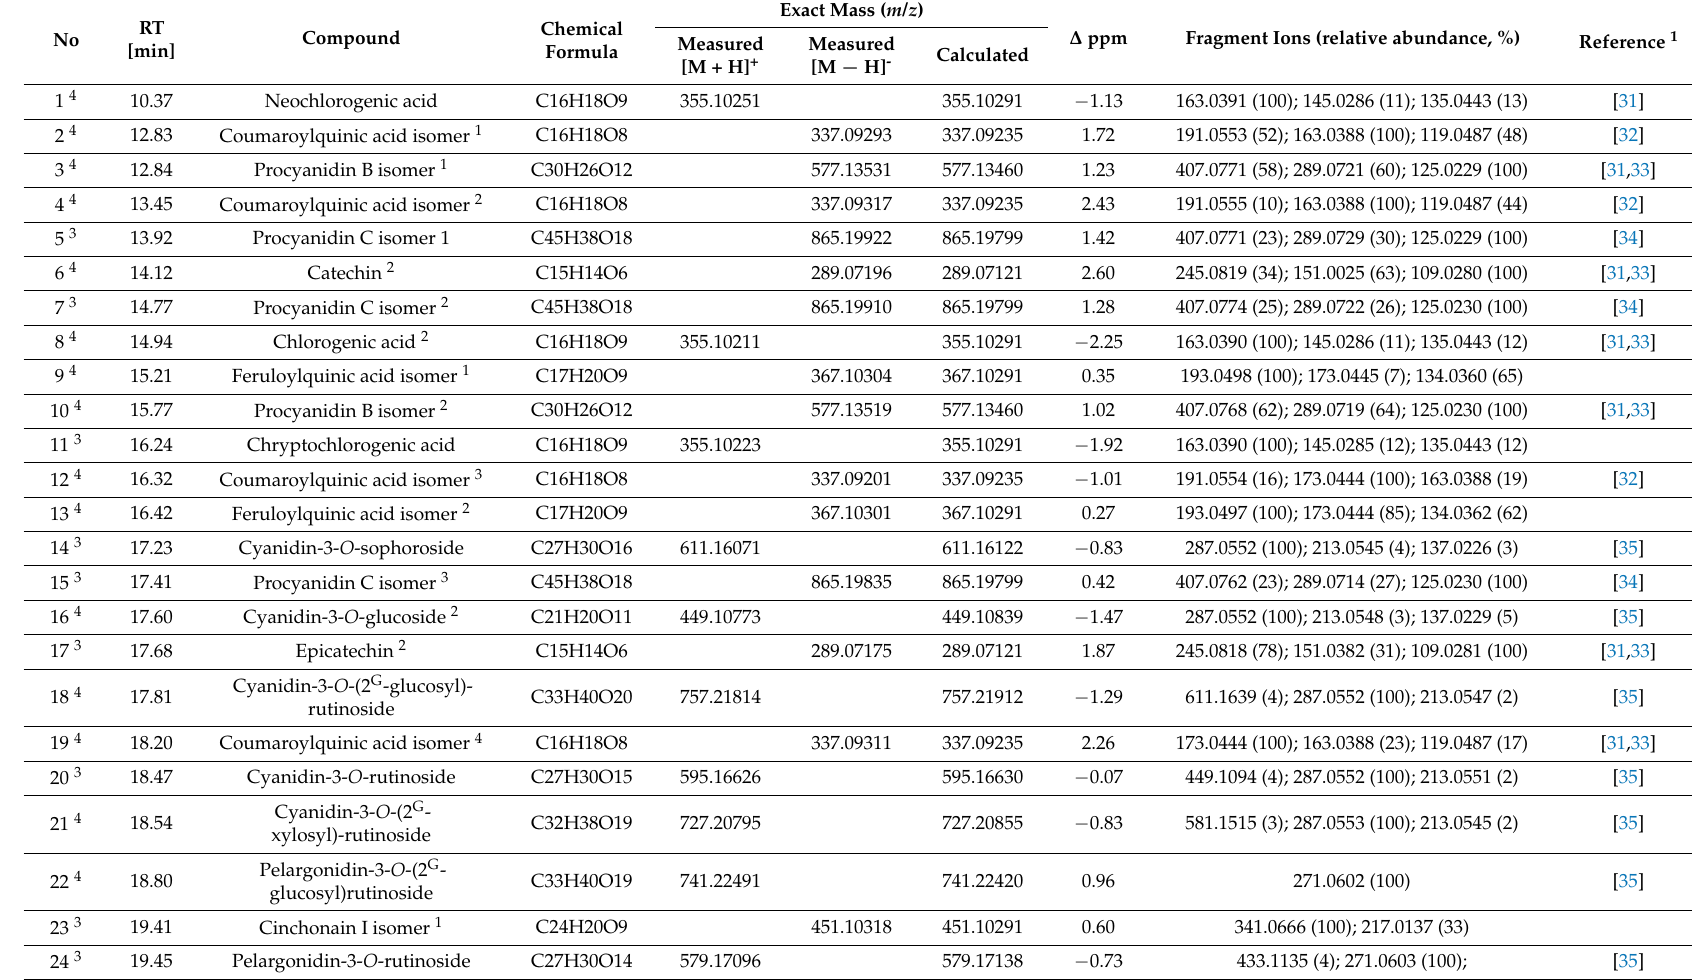
Table 1. Polyphenolic compounds identified by LC-MS in Prunus cerasus L.